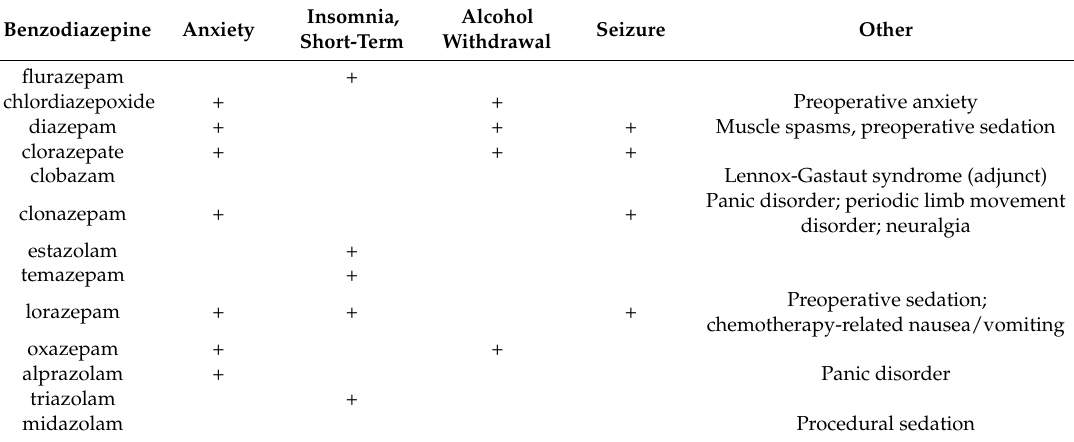
Table 1. Food and Drug Administration (FDA) approvals for